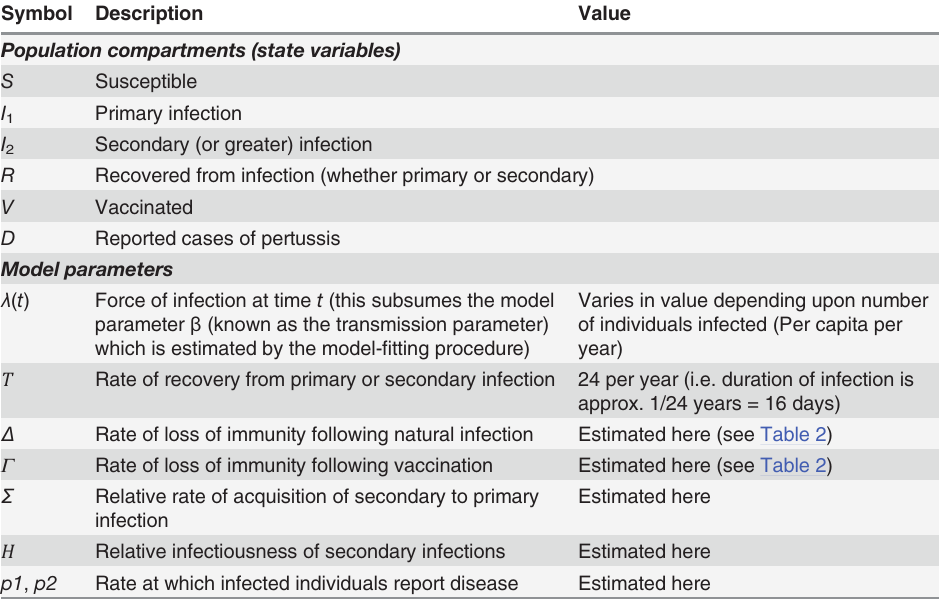
Table 3. State variables (population compartments) and model parameters for the model